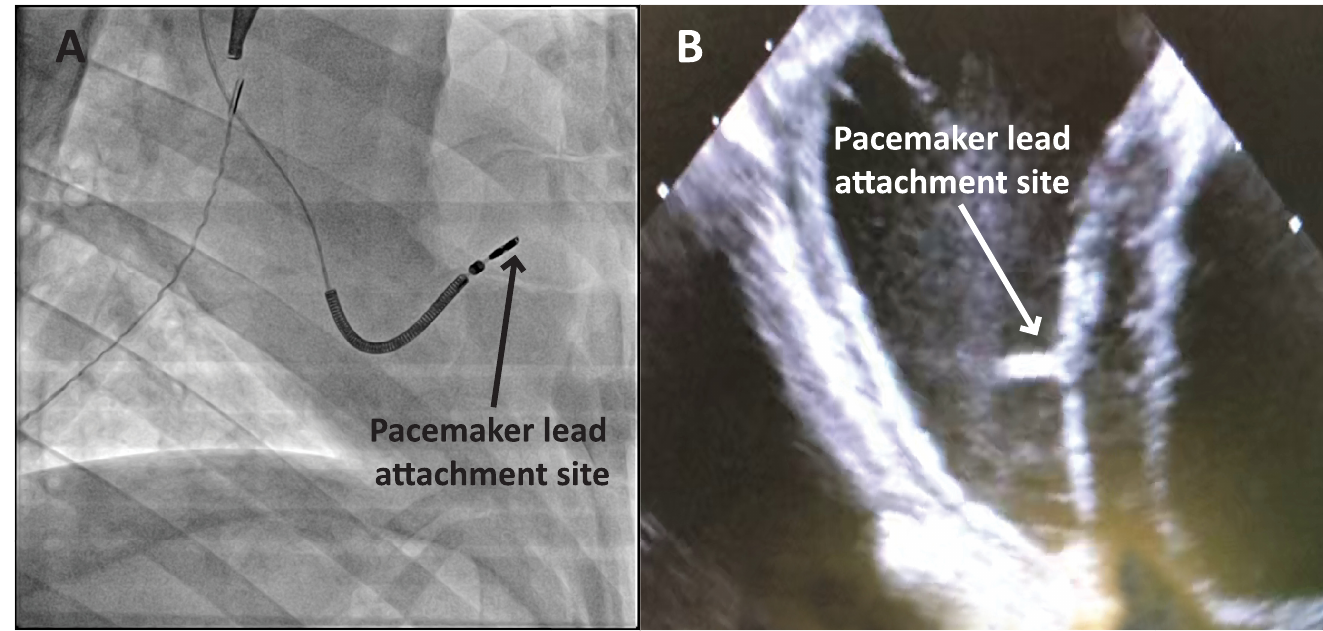
Fig 3. Representative fluoroscopy and ICE confirm attachment site of ventricular leads at the RV septal wall. (A) Fluoroscopic image showing the ventricular lead attached at the RV septal wall. (B) ICE recording confirming the ventricular lead attached at the RV septal wall.